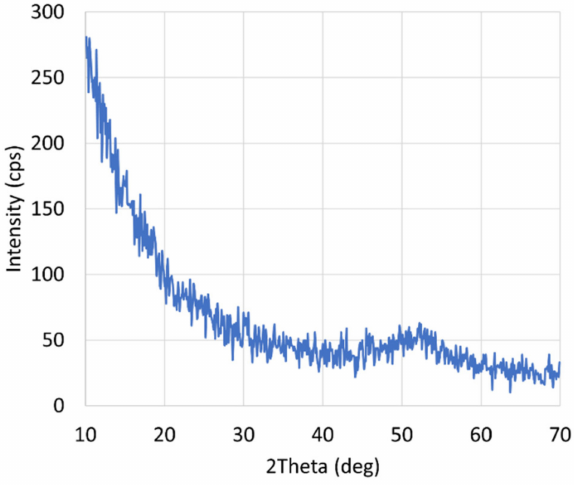
Figure A1. Typical XRD-spectrum of a boron thin film realized by